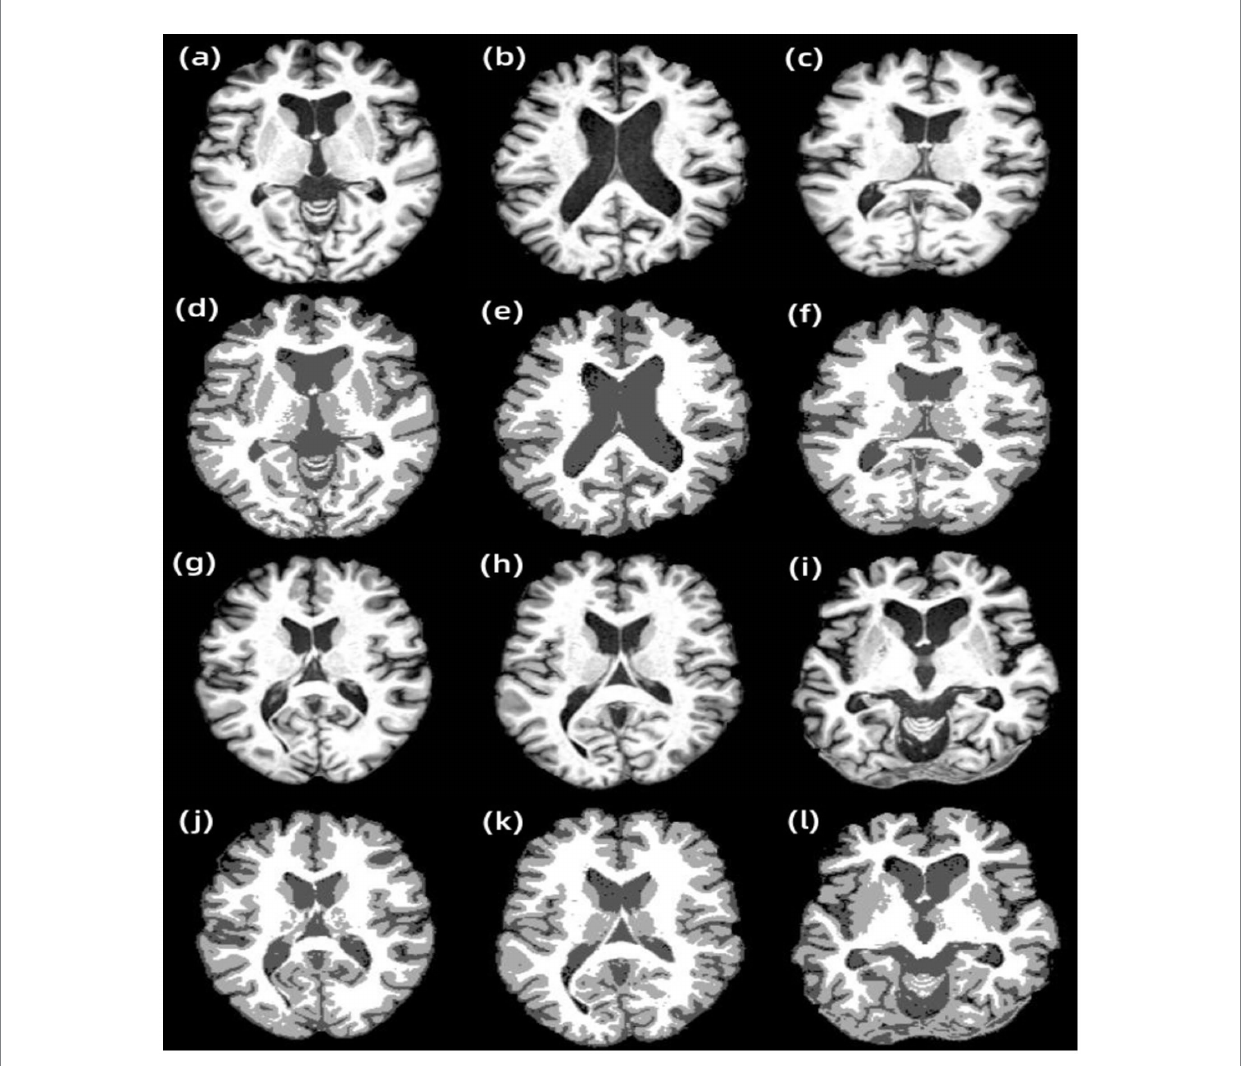
FIGURE 5 Results of other examples of AR-FCM algorithm segmentation. (A) Subject 1, (B) subject 2, (C) subject 3, (D) subject 1 segmentation result, (E) subject 2 segmentation result, (F) subject 3 segmentation result, (G) subject 4, (H) subject 5, (I) subject 6, (J) subject 4 segmentation result, (K) subject 5 segmentation result, and (L) subject 6 segmentation result.